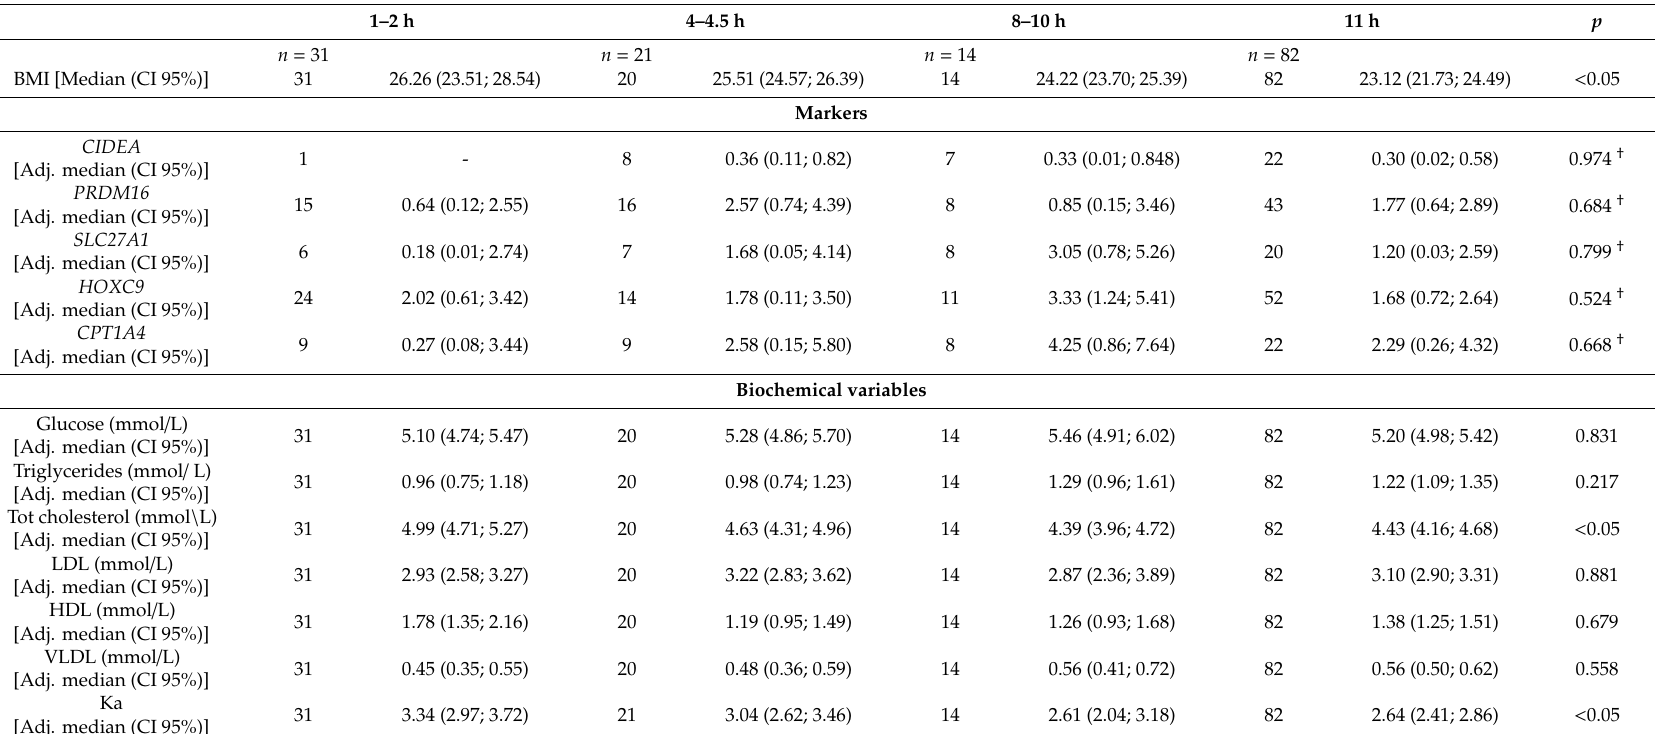
Table 4. PBMC markers and biochemical variables comparison within the cold exposed group based on time of exposure to